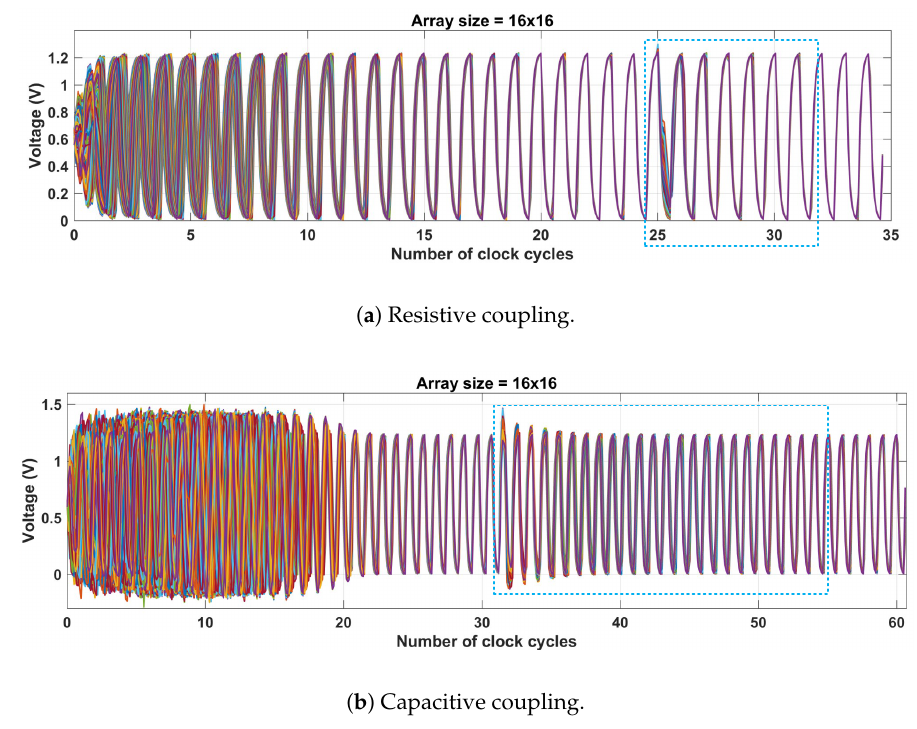
Figure 6. Voltage waveforms of a 16 × 16 coupled RO network under ± 15% random initial conditions and with disturbance introduced in 32 ROs in the case of ( a ) resistive coupling with R c = 250 Ω and ( b ) capacitive coupling with C c = 240